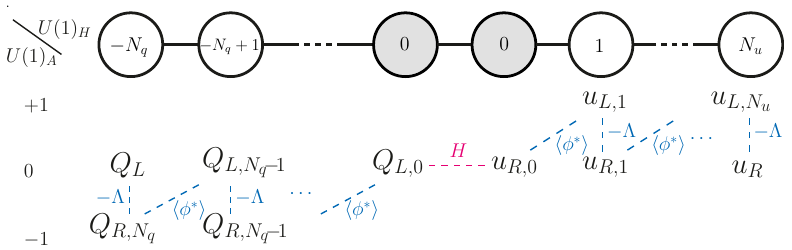
Figure 7 . The clockworked FN chain that naturally leads to the clockwork model of (cid:13)avor. The chiral fermions on the greyed-out Higgs node do not carry a horizontal